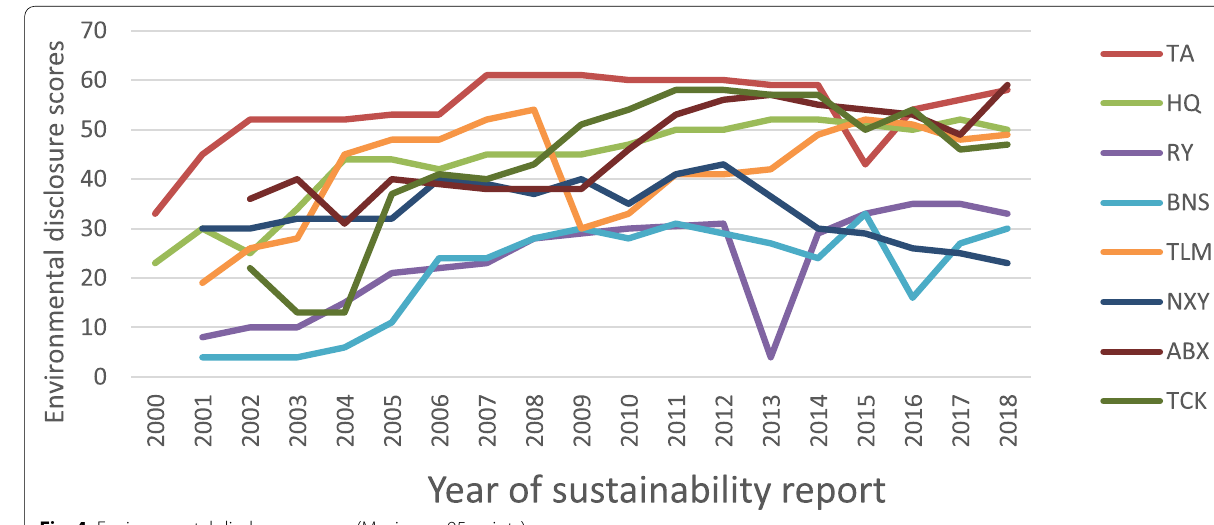
Fig. 4 Environmental disclosure scores (Maximum 95 points)